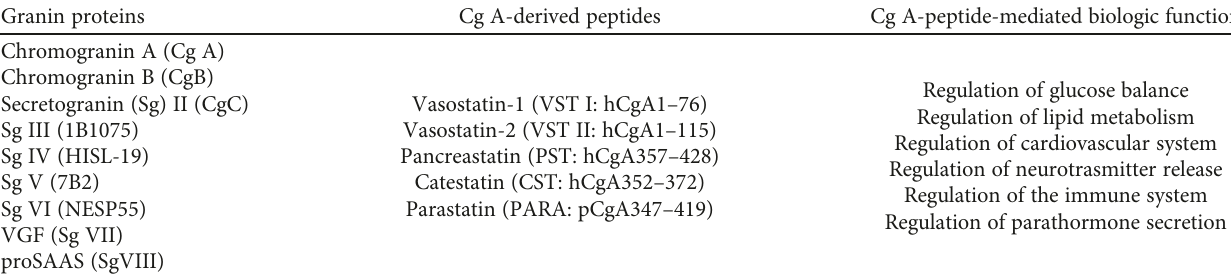
Table 1: The granin family and biological functions mediated by Cg A-derived